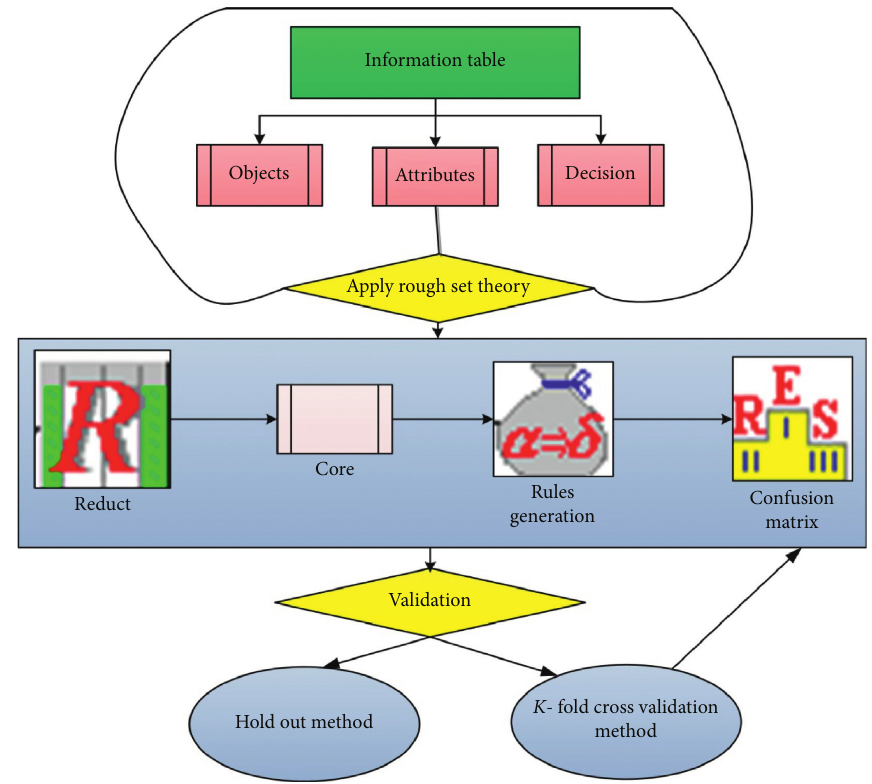
Figure 15: Generic rough set